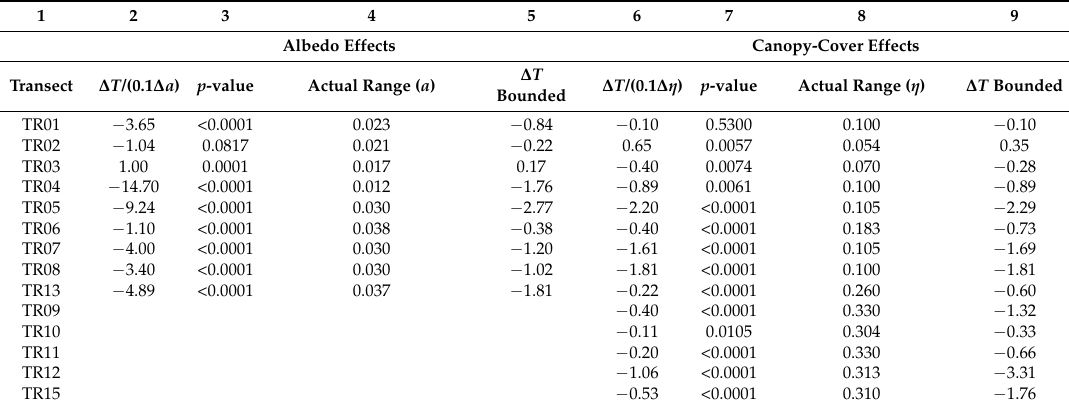
Table 4. Summary of observed transect temperature response to changes in neighborhood scale (500